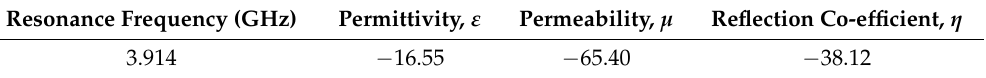
Figure 5. Simulation performance of the proposed sensor with regard to ( a ) Permittivity ( ε ); ( b ) Permeability ( μ ); ( c ) Refractive index ( η ); ( d ) Absorption with the focused frequency spectrum. Table 2. The double negative (DNG) property of the metamaterial-inspired glucose sensor.